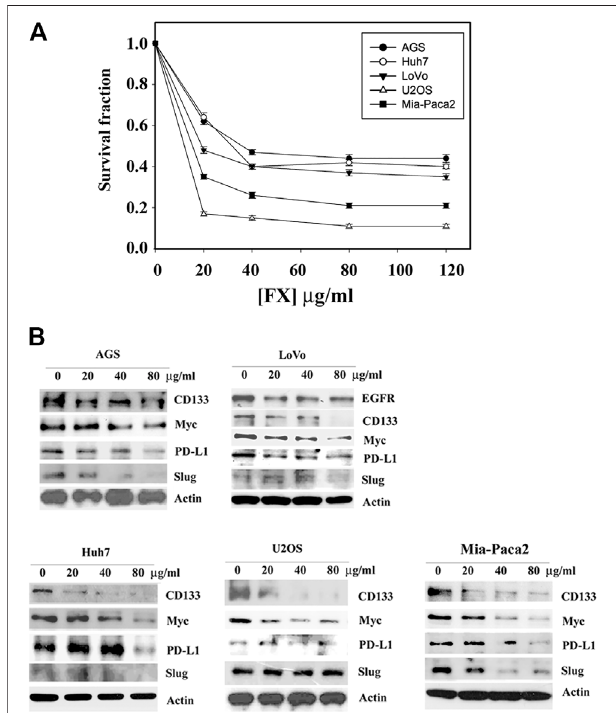
FIGURE 2 | Formula X inhibits cell growth and suppresses oncogenic protein expression in a wide spectrum of cancer cells. (A) The indicated cells were treated with a serial dose of Formula X (FX) for 4 days. The level of surviving cells was determined by MTT assay. All data were obtained from at least two independent experiments. The survival fraction showed the fold change relative to the levels of the untreated control. The data are presented as the mean ± SD. (B) The cells were treated with various doses of Formula X for 24 h. The lysates were prepared, and the effect of Formula X on theselectedproteinexpressionasindicatedinthe fi gurewascharacterizedby Western blotting analysis. Actin staining served as a loading